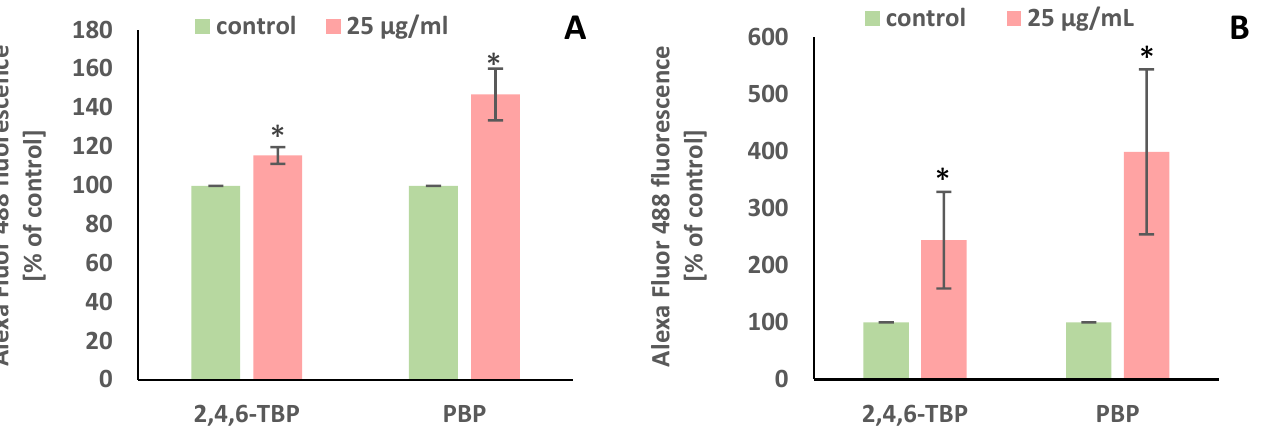
7 of 18 Figure 4. Changes in the activity of caspase-8 ( A ), -9 ( B ), and -3 ( C ) in human PBMCs incubated with 2,4,6-TBP and PBP in concentrations ranging from 1 to 25 µg/mL for 24 h. Means ± SDs were calcu- lated from four individual experiments (four blood donors). Results were statistically different from negative control at * p < 0.05. Statistical analysis was conducted using one-way ANOVA and a pos- teriori Tukey test. After 24 h of incubation, 2,4,6-TBP and PBP at 5 µg/mL and particularly at 25 µg/mL caused significant increases in caspase-9 activity in PBMCs. It was also noted that 2,4,6- TBP at its highest concentration increased caspase-9 activation more strongly than PBP in the tested cells (Figure 4B). Caspase-3 is an executioner caspase of apoptosis. It was found that after 24 h of incu- bation 2,4,6-TBP and PBP at 5 µg/mL and, more strongly, at 25 µg/mL increased caspase- 3 activation in the tested cells, and the effects induced by these substances were similar (Figure 4C). In all three experiments, preincubation with caspase-8, caspase-9, and caspase-3 in-